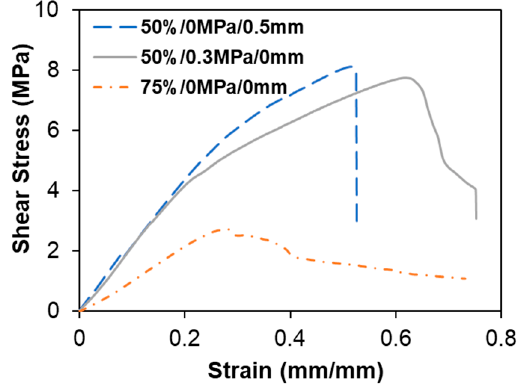
Figure 6. The stress–strain curves for 75% graphite coverage with no pressure or displacement (orange dotted line); for 50% coverage, 0.3 MPa, and 0 displacement (grey solid line); and for 50% coverage, 0.5 mm displacement, and no pressure (blue dashed line).